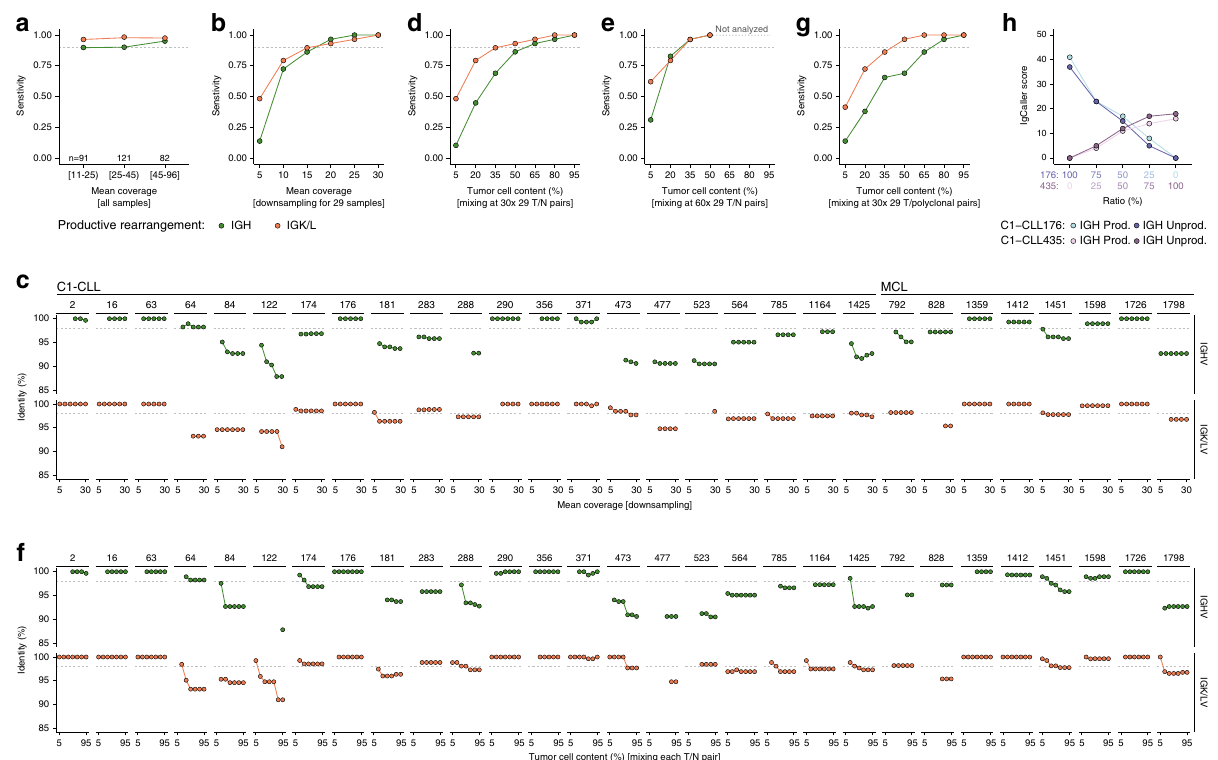
Fig. 4 Sequencing depth and tumor purity requirements for IgCaller. a Sensitivity of IgCaller to detect a complete and productive IGH or IGK/L rearrangement at different ranges of coverage for CLL and MCL cases. b Downsampling experiment with 29 tumor samples. The sensitivity of IgCaller is shown for each speci fi c mean coverage analyzed. c Identity for IGH (top) and IGK/L (bottom) gene rearrangements for each case at different downsampling conditions. d Sensitivity of IgCaller at distinct tumor cell contents after mixing tumor/normal (T/N) pairs at different ratios. The mean depth was set to 30×. e Similar to d but with a mean depth of 60×. Note that only purities of 50%, 35%, 20%, and 5% were analyzed. f Ig gene identity according to tumor cell content in different T/N mixing conditions. g Sensitivity of IgCaller when tumor samples are mixed with a polyclonal-like population. h Oligoclonal situation created in silico by mixing at different ratios two tumor samples carrying two IGH rearrangements each; one productive (Prod.) and one unproductive (Unprod.). The score of each rearrangement according to IgCaller is shown. A score of 0 is used for illustrative purposes for rearrangements not identi fi ed in a speci fi c mixing condition. The score is calculated based on the number of reads supporting each rearrangement ( “ Methods ” ). Source data are provided as a Source data fi